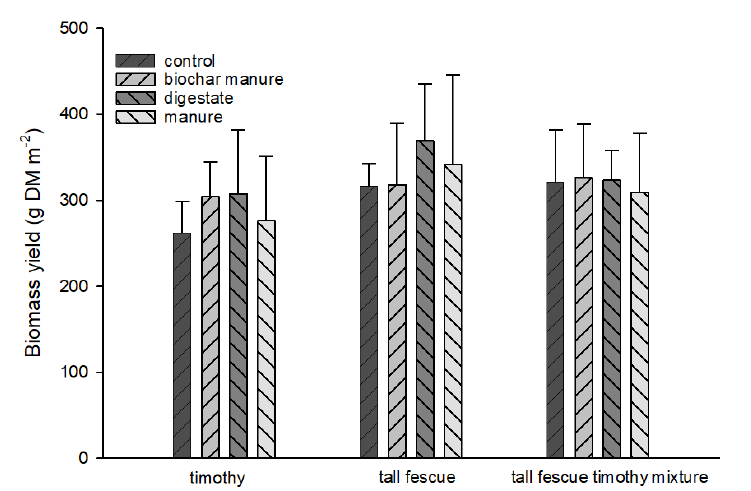
Fig. 3. Seasonal biomass yield of timothy, tall fescue and a timothy-tall fescue mixture in the four treatments at Skierniewice, Poland, in 2018. Error bars indicate 95% confidence